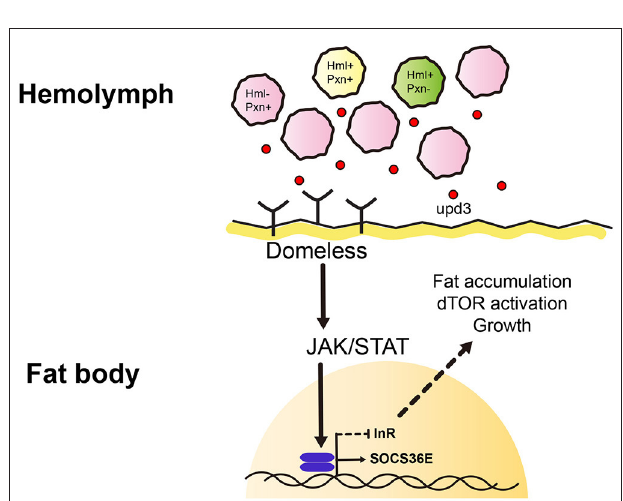
FIGURE 5 | Working model of this study. We identified heterogenic expression of larval plasmatocytes based on two genetic markers, Hemolectin ( Hml ) and Peroxidasin ( Pxn ). There are Hml + Pxn + (yellow), Hml + Pxn − (green), and Pxn + Hml − (pink) plamatocytes which show definitive distributions across 72, 96, 120h AEL developmental time points. This suggests plasmatocyte proportions are constantly maintained during development. Pxn + hemocyte (pink) is increased when Hml + hemocytes are ablated. Also, total remaining hemocytes emit a cytokine, upd3 (red dot). upd3 increases JAK/STAT signaling in the fat body which possibly inhibits insulin receptor signaling, and consequently affects growth and